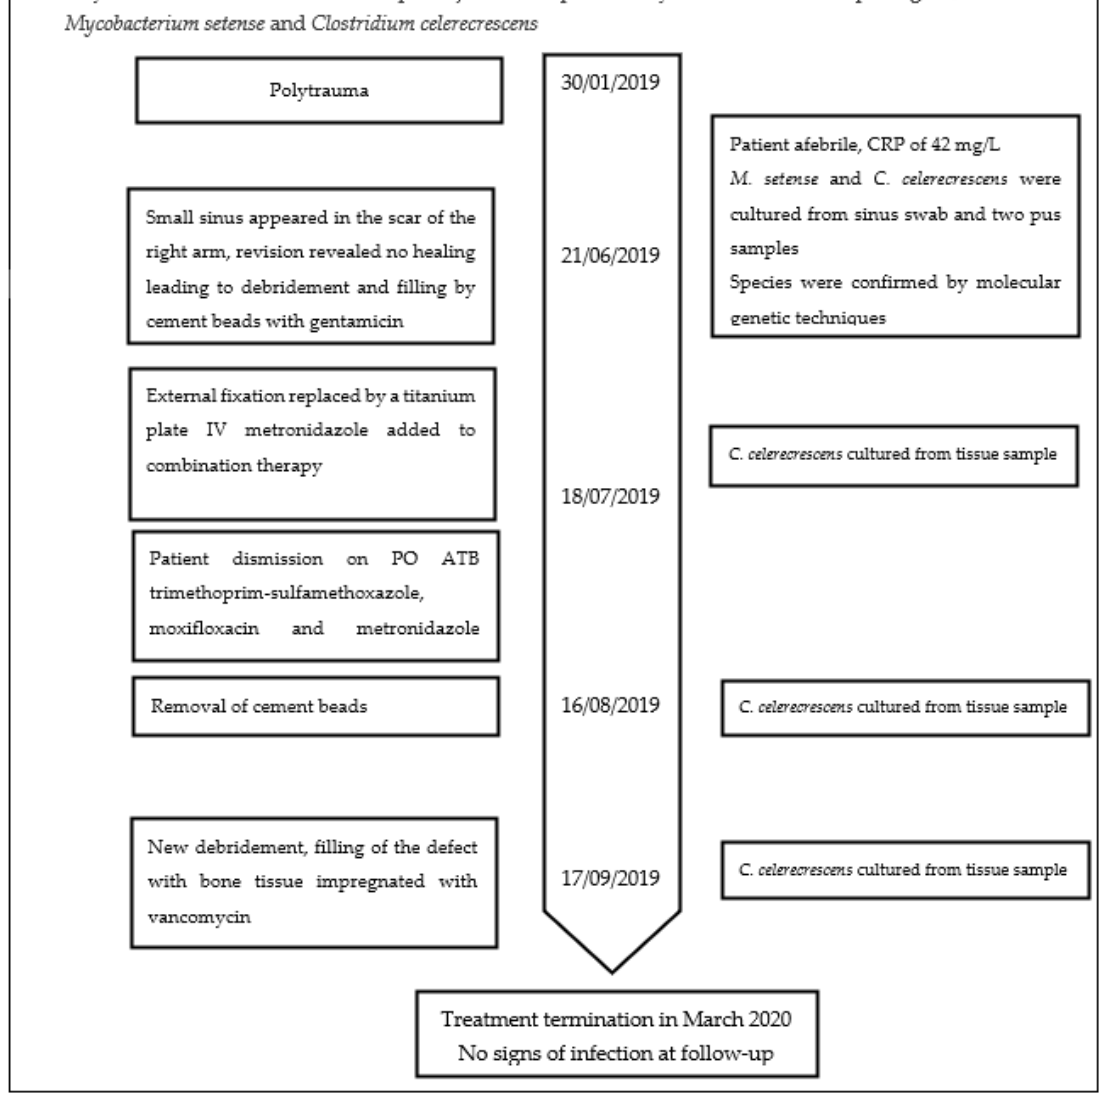
Figure 3. The timeline of the case developments.